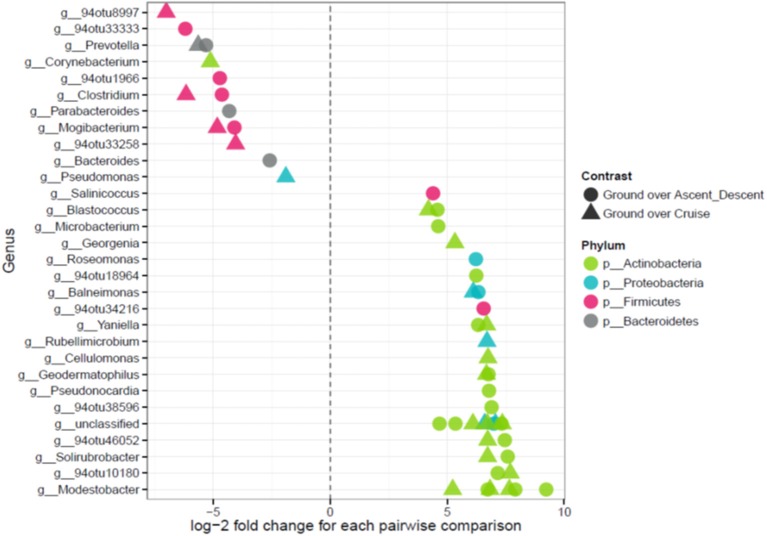
Points on the left depict OTUs in Ascent/Descent and Cruise samples that were more abundant compared to Ground samples; points on the right depict OTUs enriched in Ground samples. Features were considered significant if FDR-corrected p-values were < 0.05 and the absolute value of the log-2 fold change was ≥ 1.